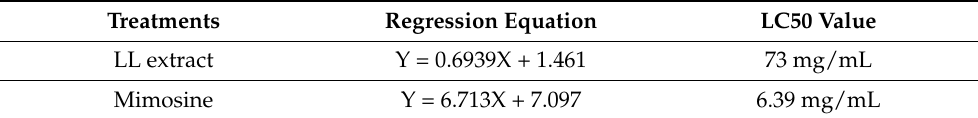
Figure 5. Toxicity of LL extract and mimosine. ( a ) Percentage mortality of C. elegans in LL extract. ( b ) Percentage mortality of C. elegans in mimosine. Data are presented as means ± SD and are compared to M9 buffer as the negative control. Statistical significance was calculated using a one-way ANOVA with Dunnett’s multiple comparison test and is denoted by asterisks. * p ≤ 0.05; ** p ≤ 0.01; Table 3. Estimated LC50 values of LL extract and mimosine.